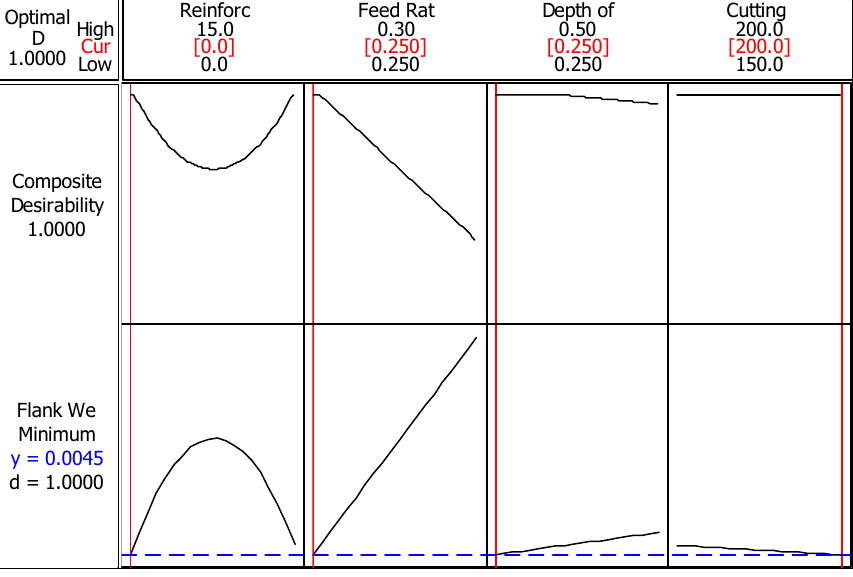
Figure 7. RSM optimization of flank wear.